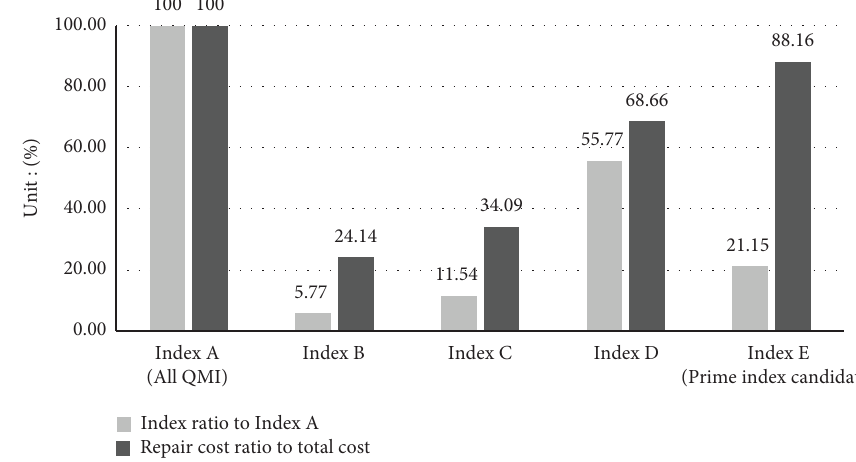
Figure 13: Pareto comparison on all